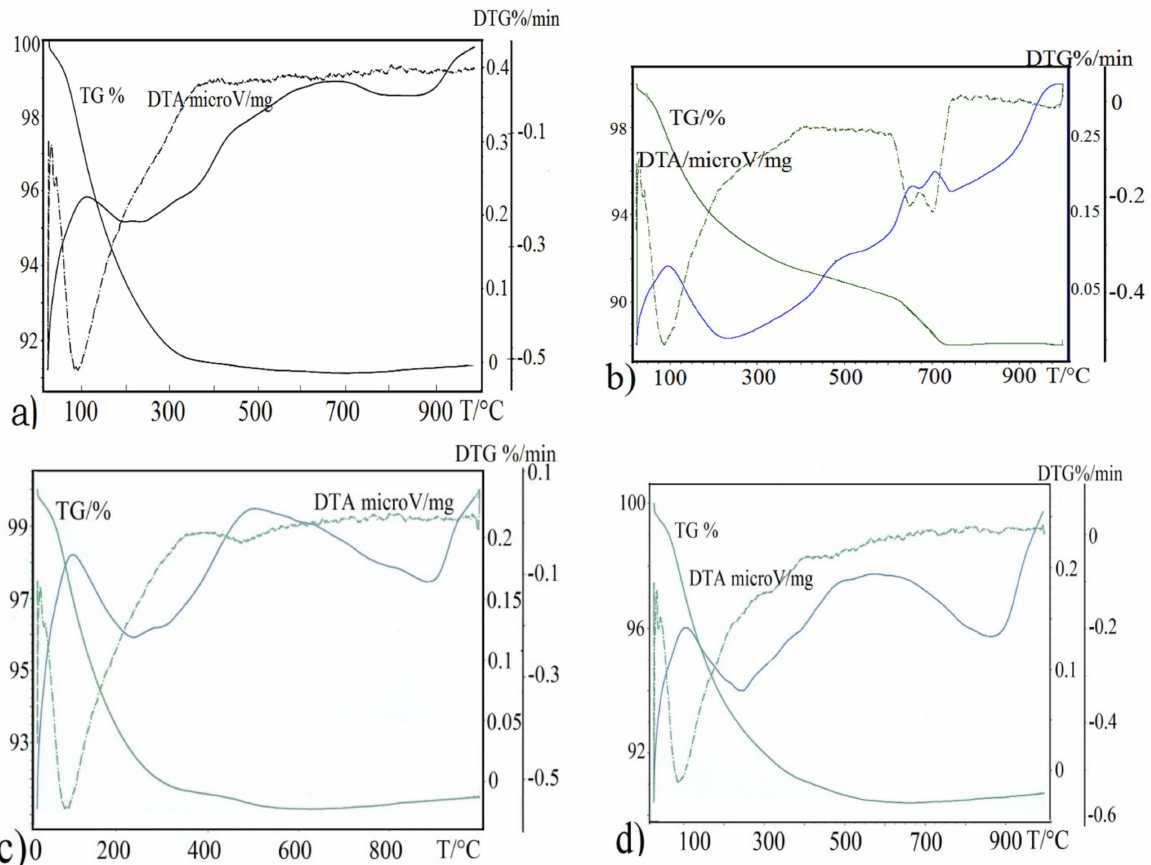
Figure 1. Thermogravimetric analyses of ( a ) natural zeolite, ( b ) MnOx-zeolite, ( c ) FeO(OH)-zeolite, and ( d ) FeO(OH)-